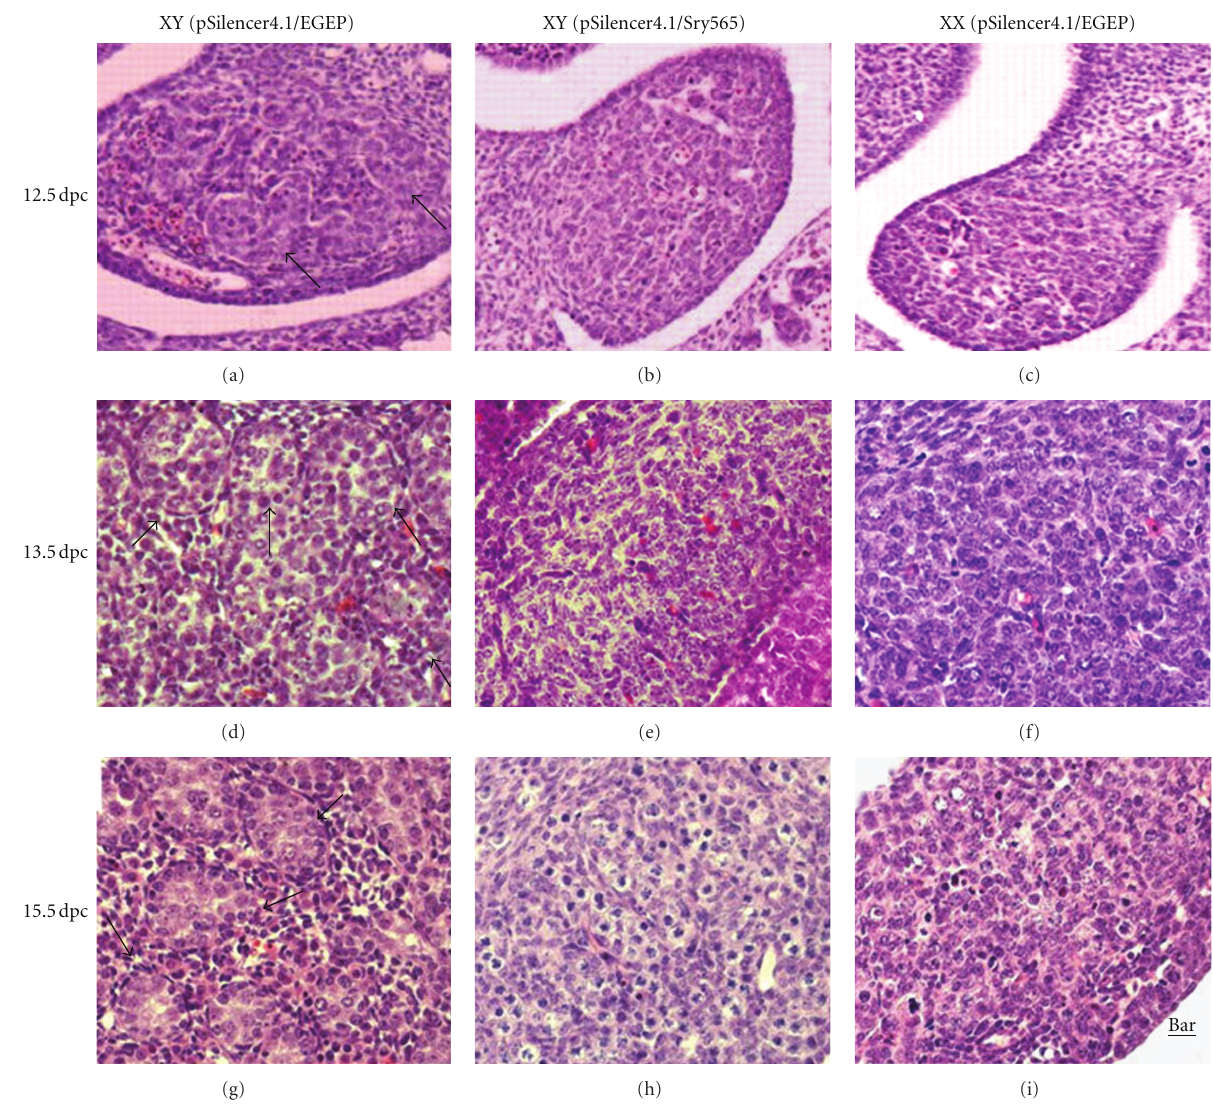
Figure 4: Feminization of male gonads following knock-down of Sry. Starting at 12.5 dpc, testis cords (arrows) are visible in the control plasmid pSilencer4.1-EGFP-treated XY male gonad (a); no signs of di ff erentiation can be observed in the control females (c) and Sry knock- down (pSilencer4.1/Sry565 treated) male gonad (b). At 13.5 dpc, clearly visible testis cords appeared in control male gonads (d), whereas in Sry knocked-down male gonad no sign of di ff erentiation was found (e), just like the control females (f). At 15.5 dpc, testis cords can be observed clearly in control males (g), While unorganized and no visible testis cords were found in Sry knocked-down male embryos’ gonads (h), developing like the control female gonad (h). The photos were taken at transverse sections; bar = 50 μ